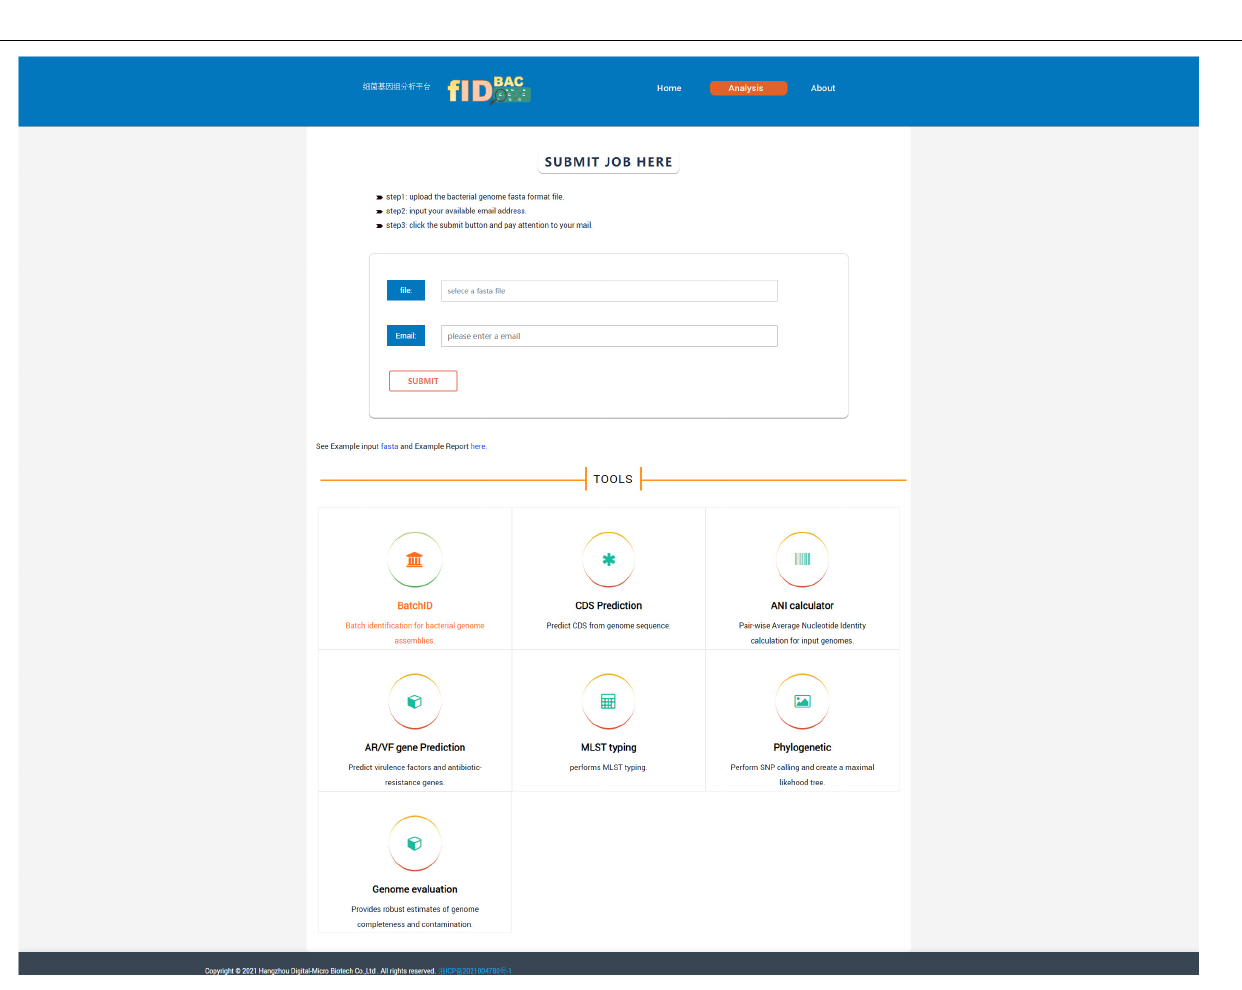
Frontiers in Microbiology |